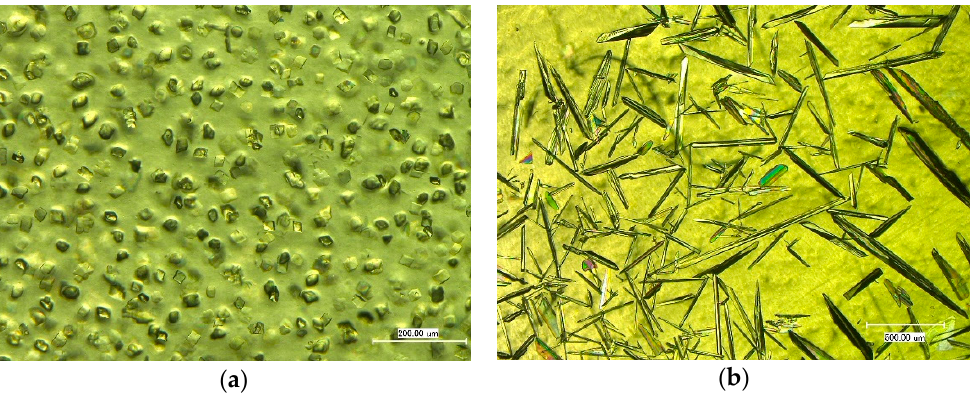
Figure 5. Light microscopy exposures of biocomposites (protein: sodium caseinate) with incorporated crystalline potassium nitrate (( a ) trigonal phase-III KNO 3 ; and ( b ) orthorhombic phase-II KNO 3 ).